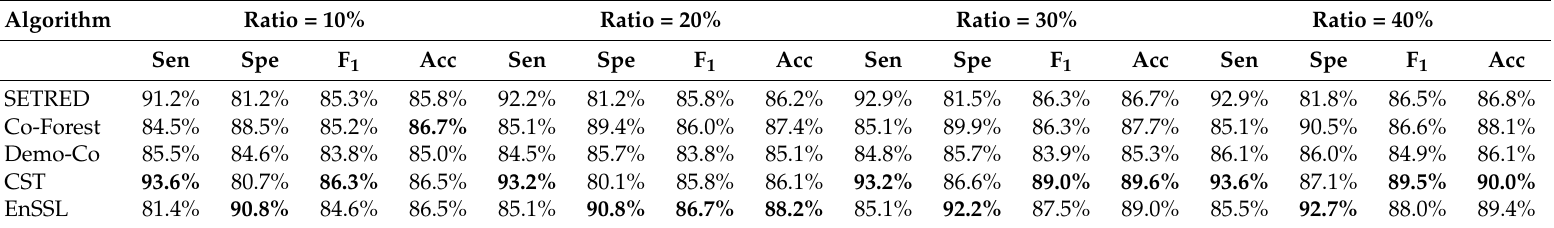
Table 7. Performance evaluation of SETRED, Co-Forest, Democratic-Co learning, CST-Voting and EnSSL on the Japanese credit dataset.